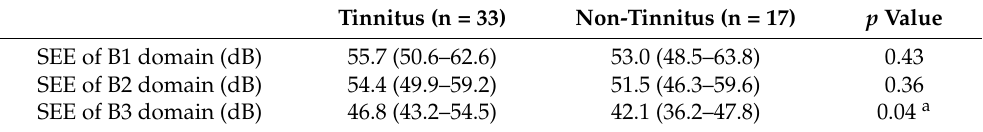
SEE of B1 domain (dB)